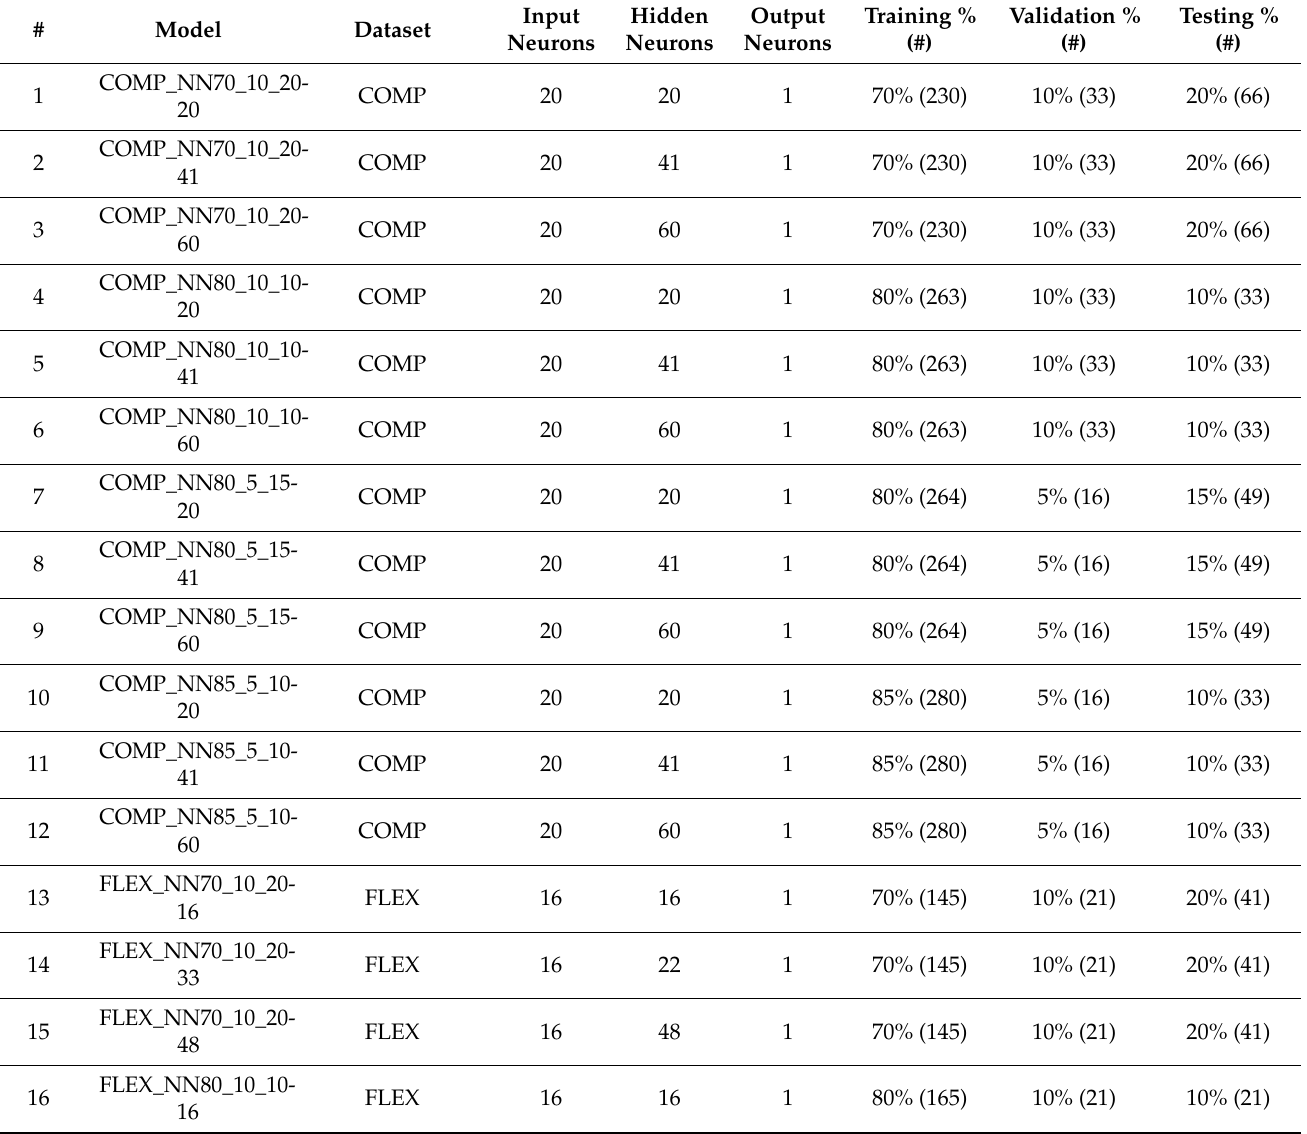
Table 6. Summary of models, their architecture, and subset